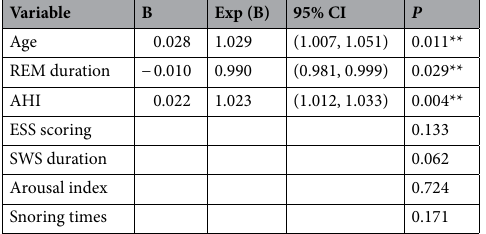
Table 2. Multivariate regression analysis of factors with PLMS among OSAS patients. ** P < 0 .05 is statistically significant.